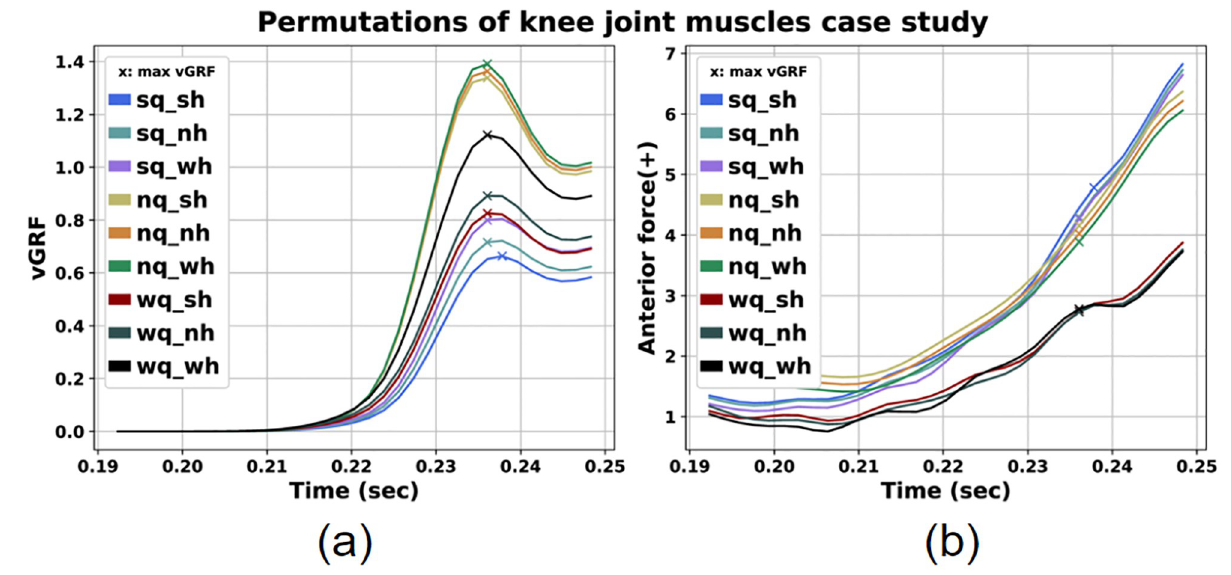
Fig 9. Vertical GRF (a) and AF (b) for the permutations of the knee joint agonists and antagonists muscles case study.